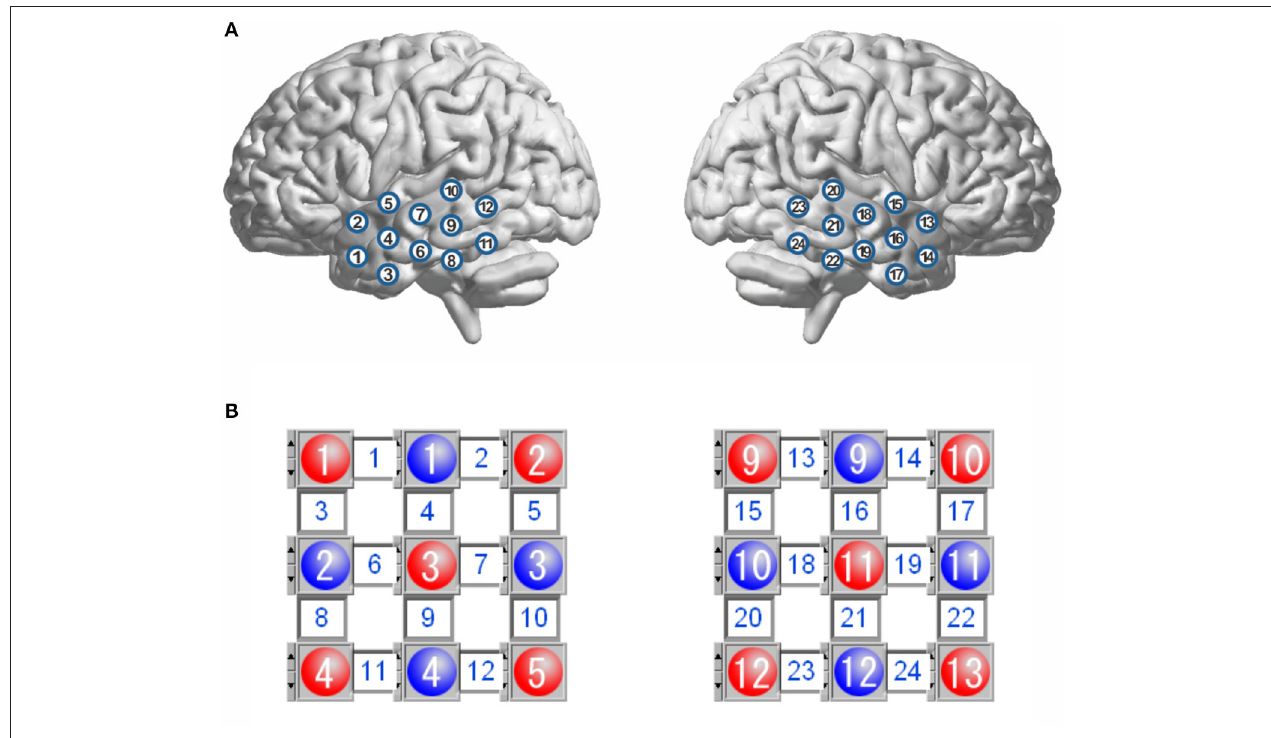
FIGURE 1 | Schematic representation of channel locations over the bilateral temporal lobes (A) , and layout for the sources and detectors (B) . The red circles represent the sources, and the blue circles represent the detectors, and the square between a source and a detector is a channel. There are 12 channels in each hemisphere.